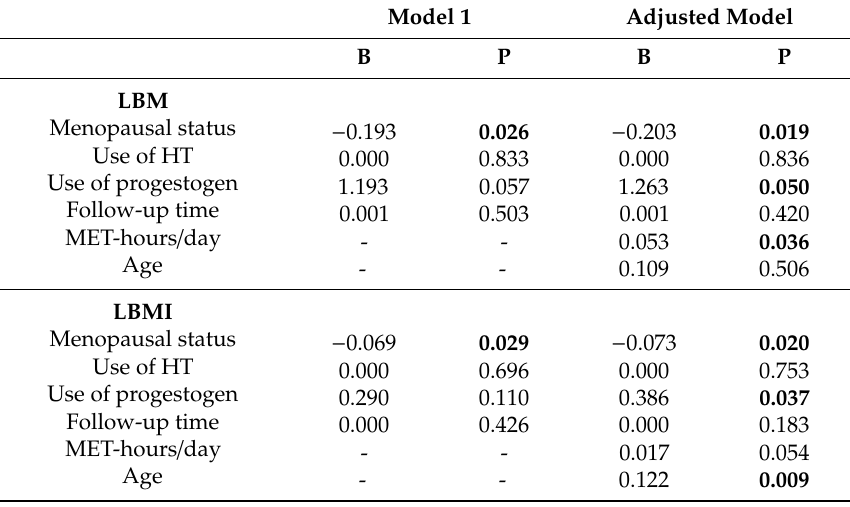
Table 4. GEE-model with self-reported MET-hours per day as a measure of physical